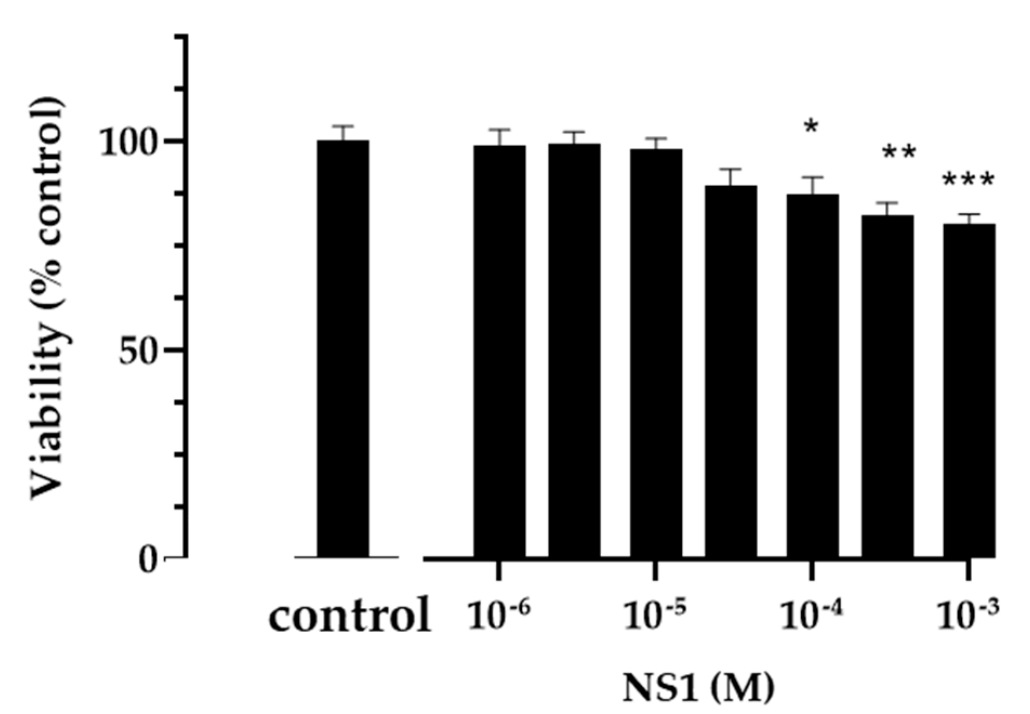
Figure 5. Smooth muscle cell viability. A7r5 smooth muscle cells were incubated for 2 h in the presence of various concentrations of NS1 (1 µM to 1 mM). Viability was estimated with a MTT assay. Results are expressed as percentage of viable cells in comparison to untreated cells (control), results are the mean +/ − SEM of 4 experiments. * p < 0.05; ** p < 0.01; *** p < 0.001) 1-way Anova.